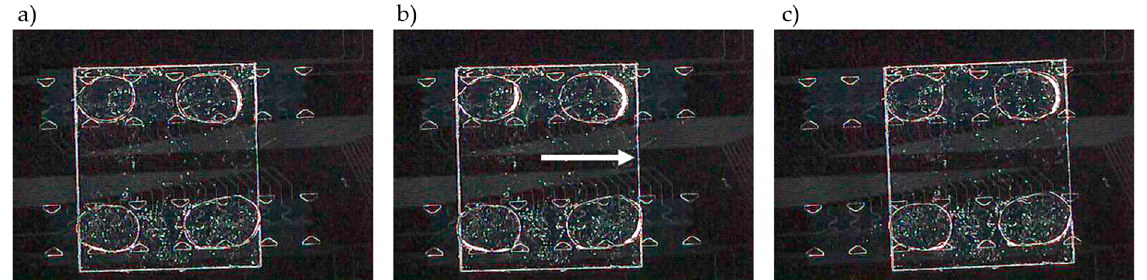
Figure 22. Four droplets moved synchronously from one stable position to the next. ( a ) Four drop- lets positioned between the photoresist barriers; ( b ) initial movement of the droplets; ( c ) four droplets reaching the next stable position, as de fi ned by the photoresist structures.